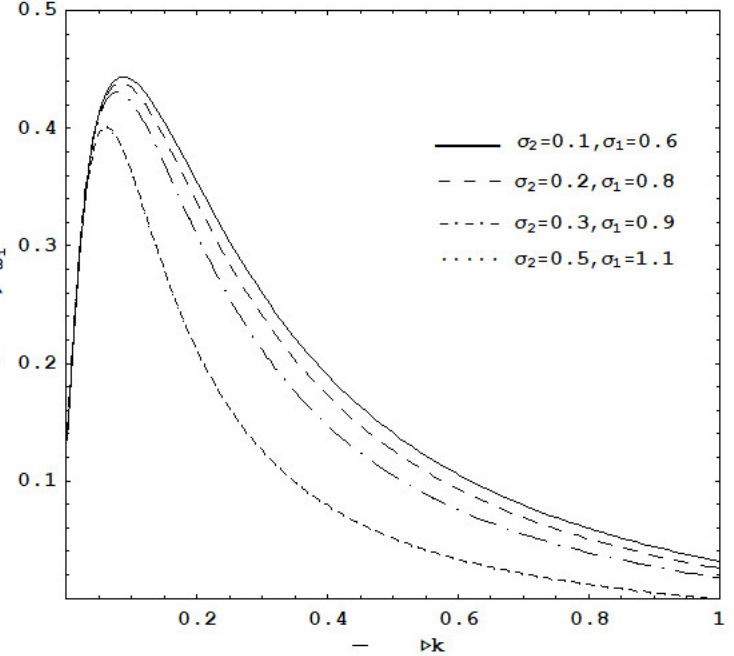
Figure 15. Variation of the growth rate ω i with the wavenumber k for different values of electrical conductivity σ 1 , σ 2